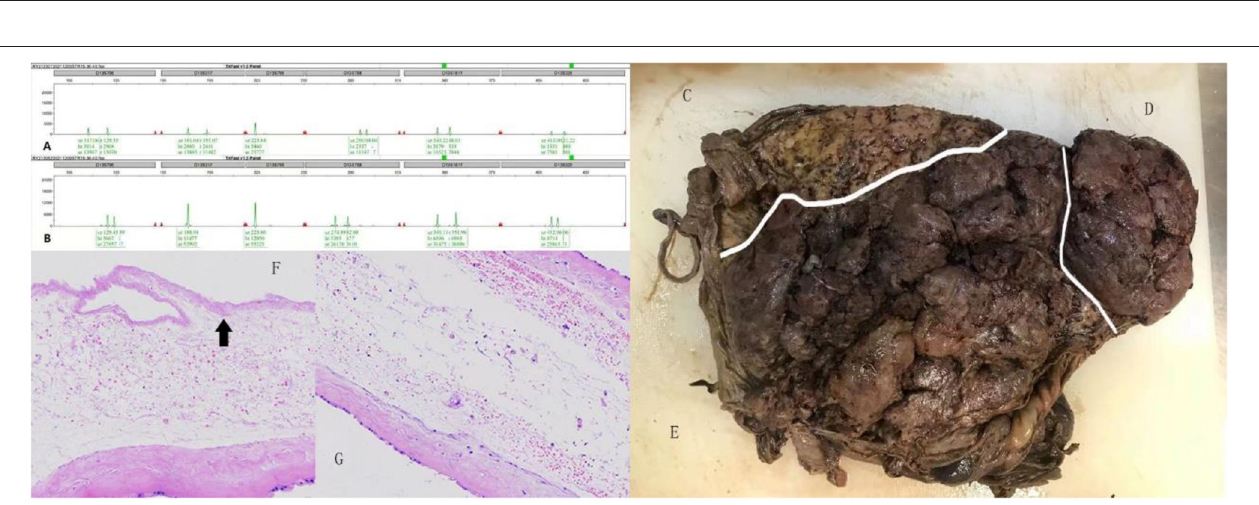
Frontiers in Medicine | www.frontiersin.org